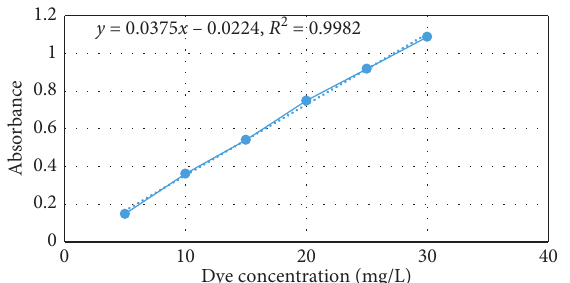
Figure 2: Calibration curve of MB dye solution at different